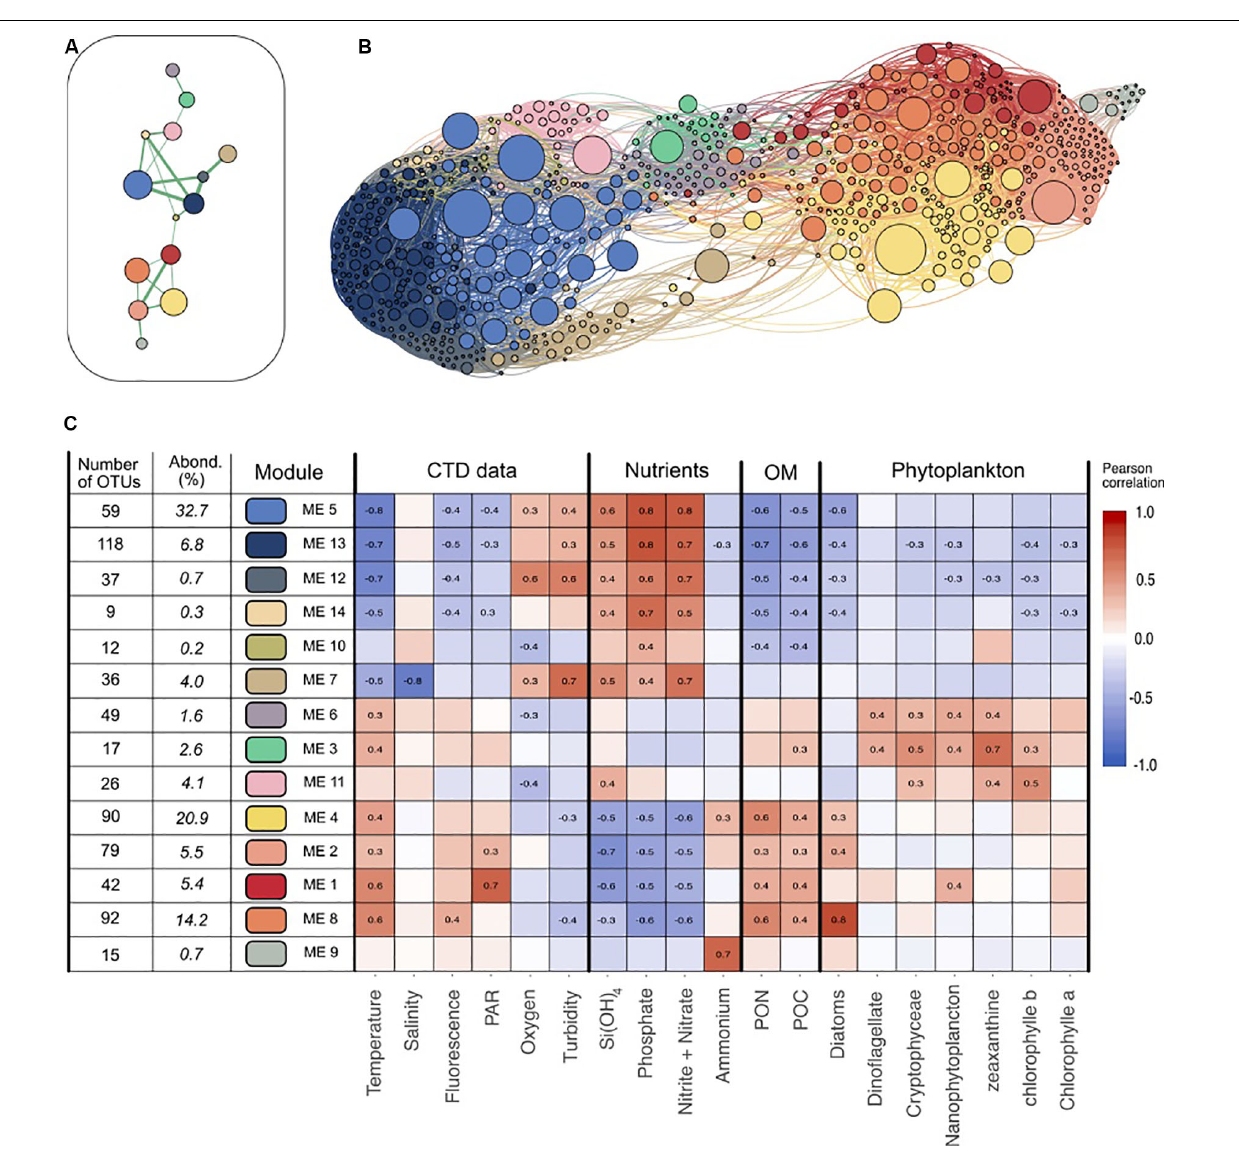
FIGURE 2 | Visualization of the different modules and their main characteristics. (A) Representation of the main connectivity between the different modules detected with the Louvain algorithm. Each node represent a module, each edge represents the median of the positive correlations between two modules. Only the strongest connections are shown. (B) Network visualization of the dataset. Each node represents an OTU, while each edge represent a positive correlation ( > 0.3) obtained from the covariance matrix calculated with SPIEC-EASI. The node size depends on the abundance of one OTU (in number of sequences) in the entire dataset. The edge size depends on the value of the correlation. Nodes colors represent the OTU affiliation to the different Louvain communities. Network was represented using Gephi and Force Atlas layout algorithm. (C) Presentation of the 14 modules detected. Pearson correlations between each module eigengene and the different environmental data are presented in the heatmap. OM, Organic Matter; PAR, Photosynthetically Available Radiation; PON, Particulate Organic Nitrogen; POC, Particulate Organic Carbon. Only the significant correlations ( p > 10–4) are shown. The number of OTUs in each module and the relative abundance of each module (in % of all the reads) are